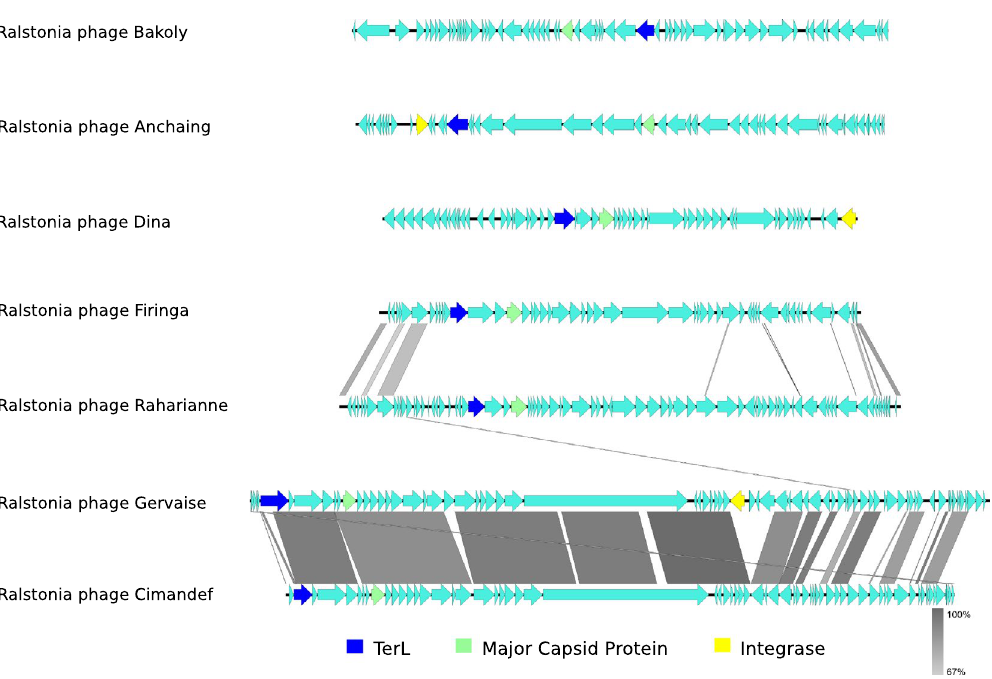
Figure 4. Synteny plot of the reference phages of each of the seven new R. solanacearum virus genera. Coding regions are represented by cyan arrows, nucleotide homology (BlastN) in grey and conserved proteins are indicated in colour codes. Figure was generated with